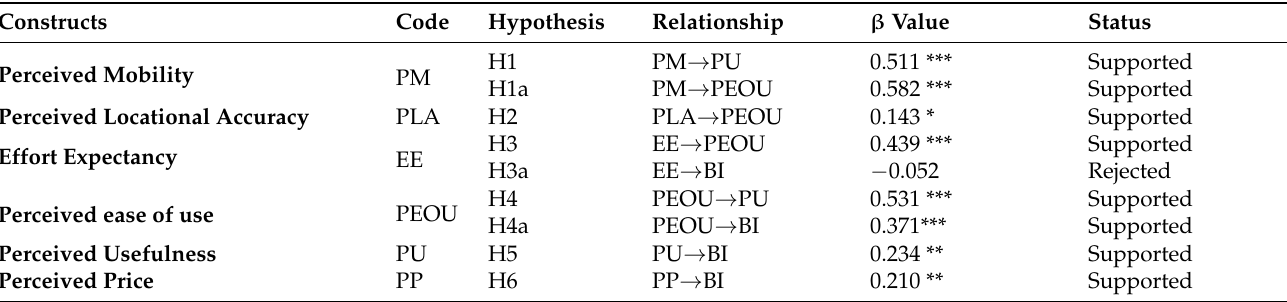
Table 9. Hypothesis